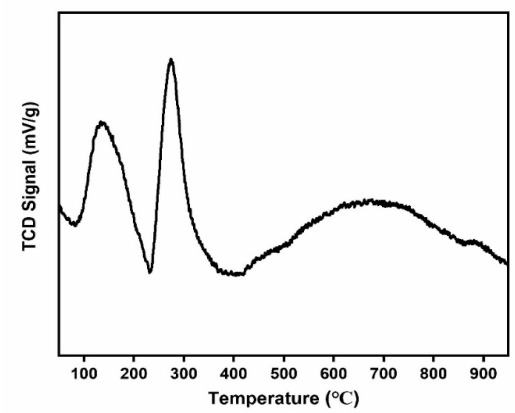
Figure 8. TPD-NH 3 spectrum of the OMSC catalyst.